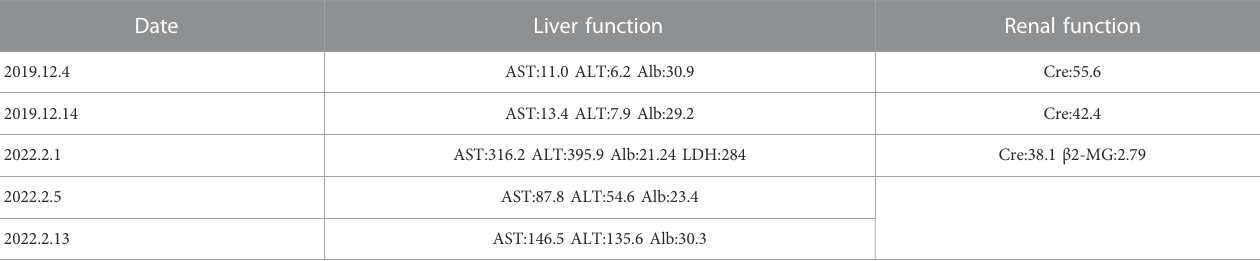
Table 2. The patient ’ s liver function was abnormal. Color Doppler ultrasound showed diffuse non-speci fi c damage to the liver parenchyma, and slightly hyperechoic nodules in the liver. Combined